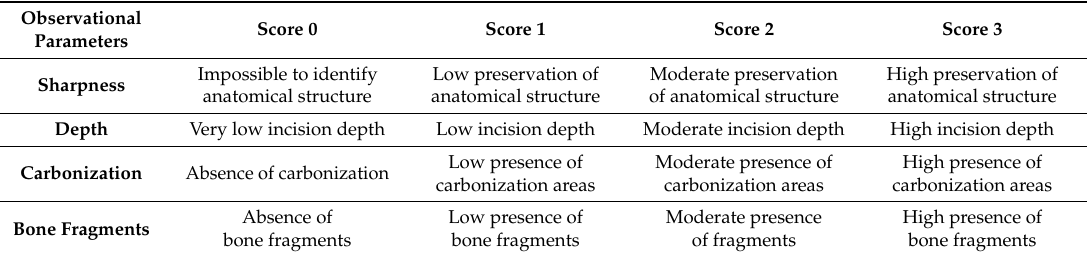
Table 3. Characteristics of each value in relation to each observational